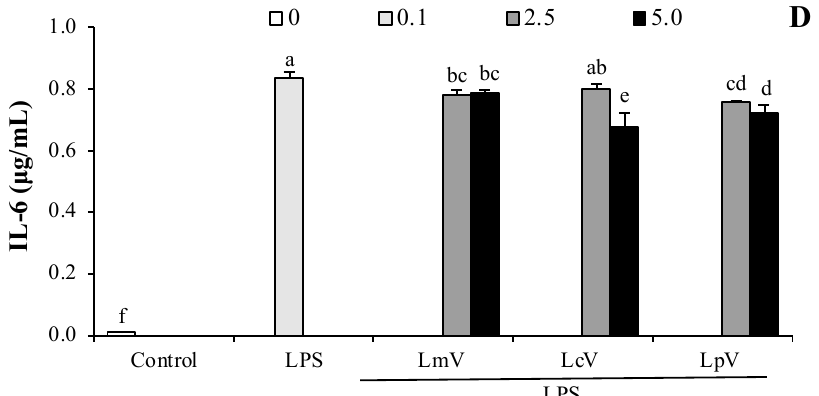
Figure 5. Effect of Le. mesenteroides, Ll. curvatus, or Lp. plantarum -derived ECVs (LmV, LcV, or LpV) on ( A ) the production of NO, ( B ) TNF- α , ( C ) IL-1 β , and ( D ) IL-6 in LPS-stimulated RAW264.7 macrophages. RAW264.7 macrophages were treated with LmV, LcV, or LpV for 2 h prior to the addition of LPS (0.5 µ g/mL), and the cells were further incubated for 24 h. Values are expressed as the mean ± SD ( n = 4) and those followed by different letters (a–i) within a property are significantly different ( p < 0.05) according to Duncan’s multiple range test.